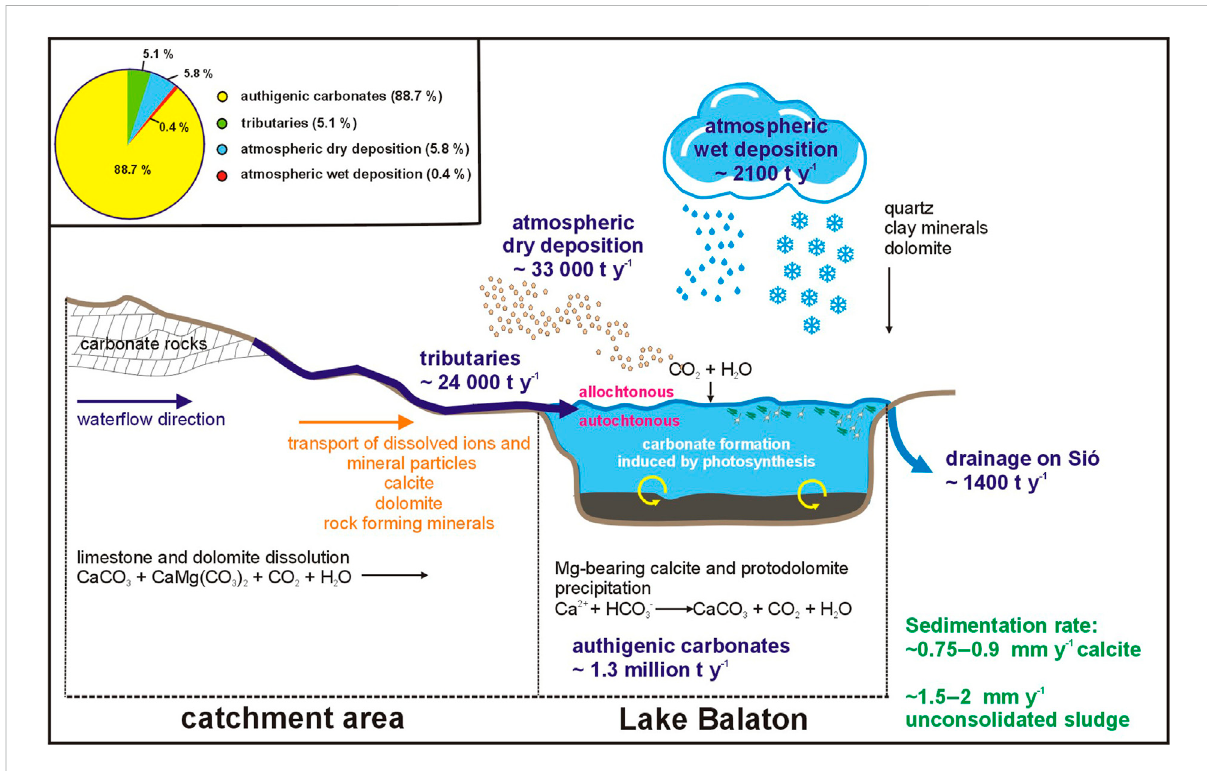
FIGURE 9 Sketch of estimated mineral budgets from distinct sources and sedimentation rates in Lake Balaton, with the main mineralogical features and controlling